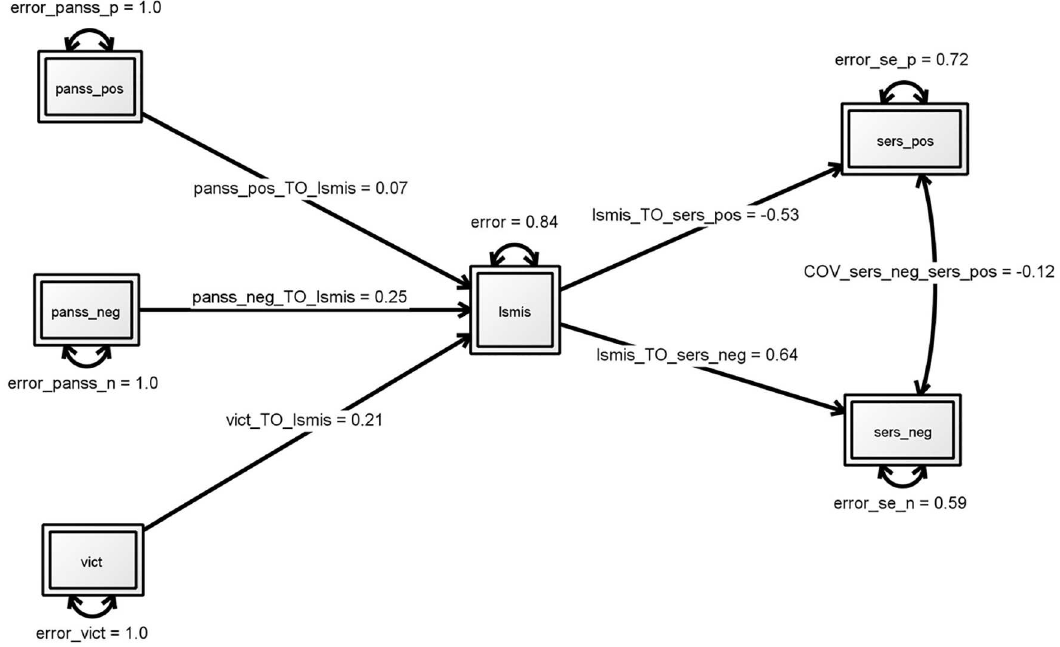
Fig 1. First model: Direct effects symptoms and victimization on stigma and effect of self- stigma on self-esteem. Structural equation modeling.Numbers by single-headed arrows reflect standardized regressionweights. Fit indices: χ 2 = 3.953; df = 6; p = .6830, RMSEA (90%CI) = .000 (0-.1), SRMR = .036, CFI = 1.000, TLI = 1.041, Akaike (AIC) 3602.784. * p < 0.05, ** p < 0.01. PANSS_pos: level of positive symptoms on PANSS, PANSS_neg: level of negative symptoms. ISMIS: total score on four subscales of the InternalizedStigma of Mental Illness Scale (alienation,stereotype endorsement, perceiveddiscrimination, social withdrawal) indicatinglevel of self-stigma. SERS_pos: score on subscale positive self-esteem of the Self-Esteem Rating Scale-Short Form and SERS-neg: subscale negative self-esteem.